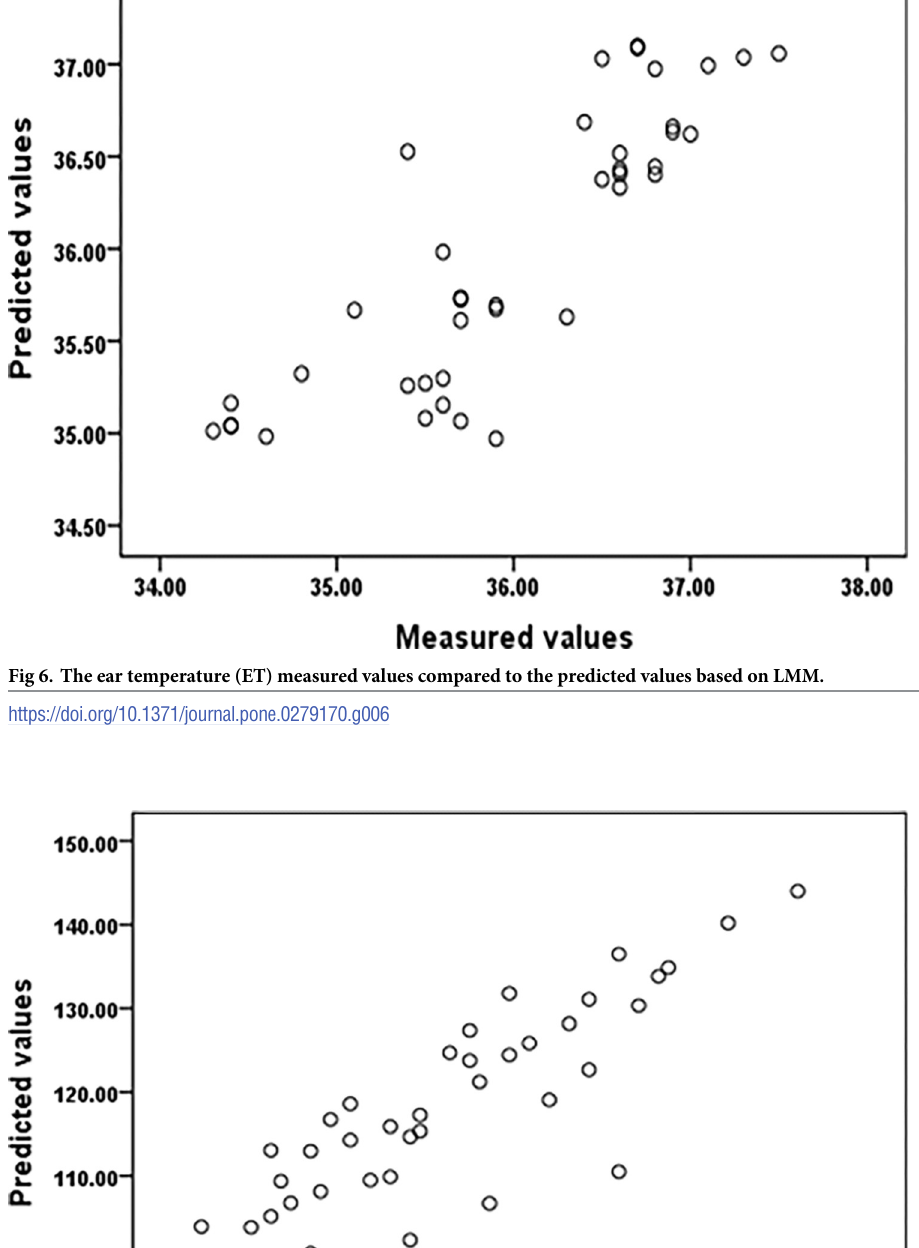
PLOS ONE | https://doi.org/10.1371/journal.pone.0279170 December22,